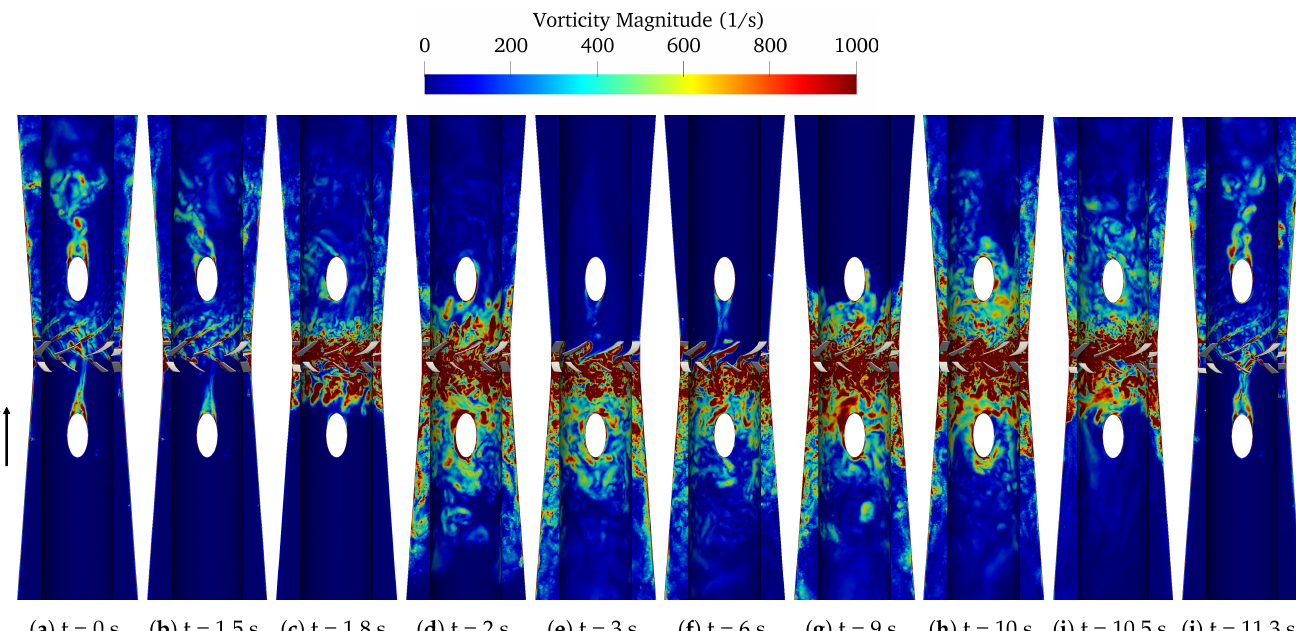
Figure 10. Zoomed-in view of the vorticity magnitude at various time steps during the transient sequences in pump mode. The results are displayed on a meridional plane and a cylinder (midpoint radius between hub and shroud) cutting the domain. The preferred flow direction is from bottom to top in pump mode.